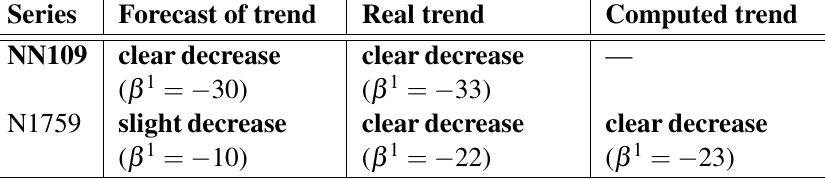
Table 2: Group G 2